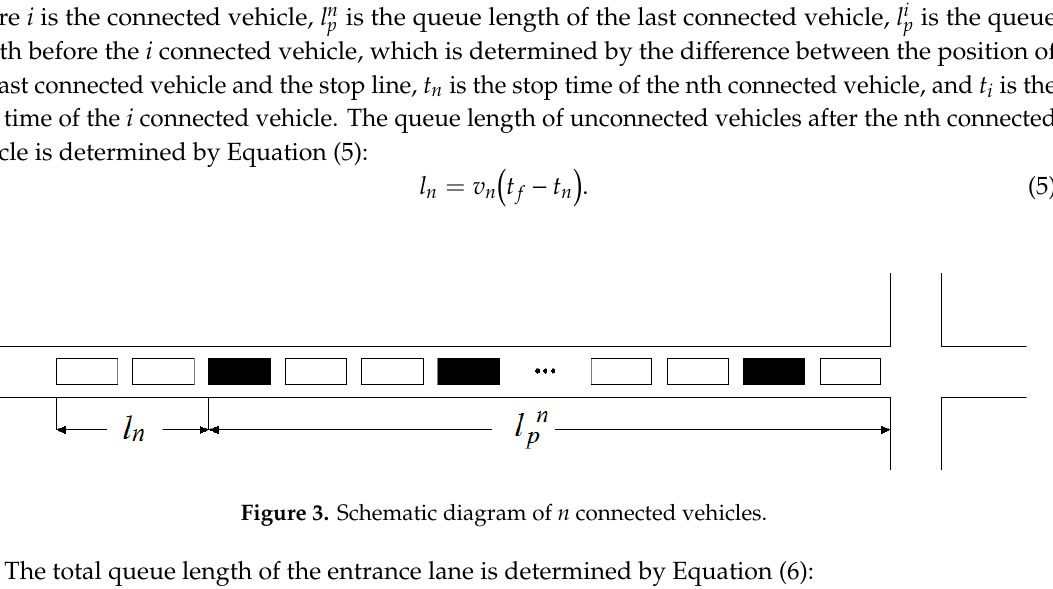
Figure 2. Schematic diagram of one connected vehicle.